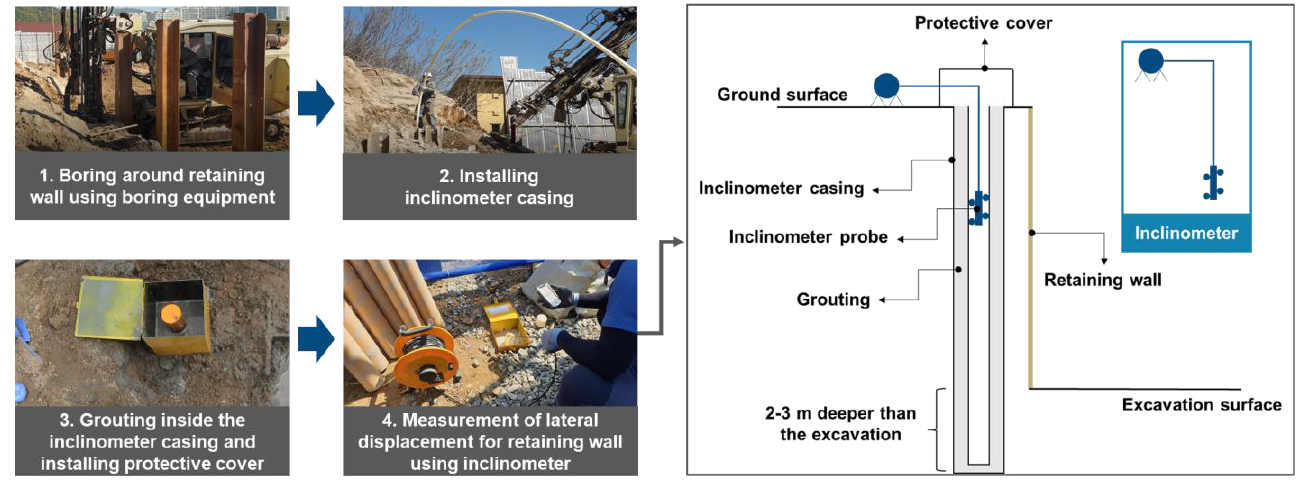
Figure 1. Inclinometer casing installation and measurement of the lateral displacement of the retaining wall using an inclinometer.